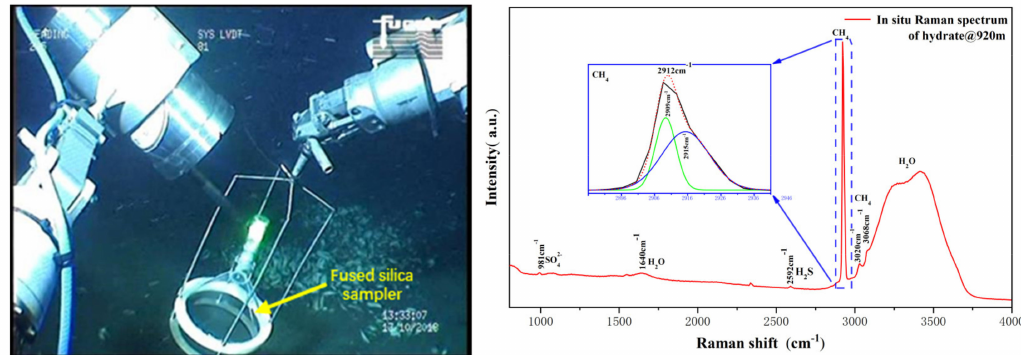
Figure 8. The image showing the easy-to-operate system is working with a fused silica sampler ( left ) and a typical spectrum obtained from the in situ formed gas hydrate ( right